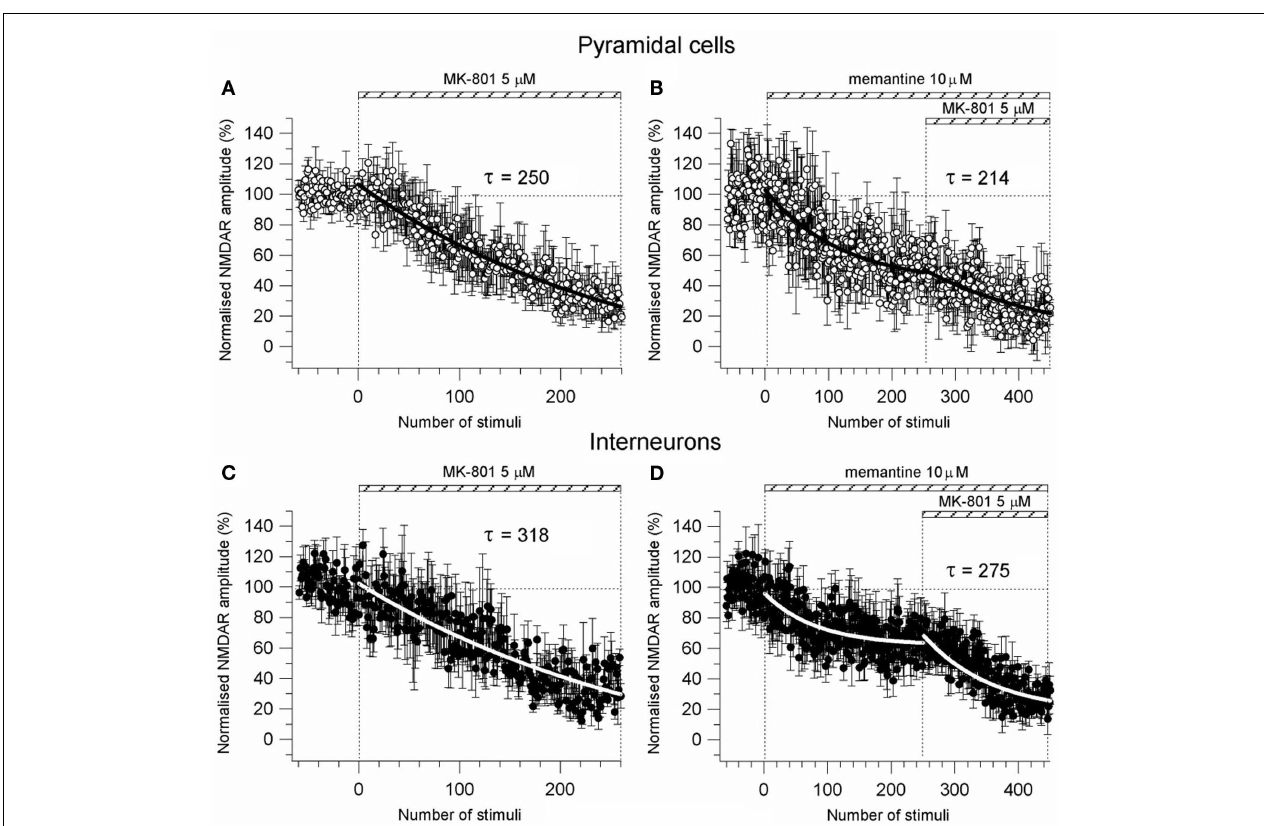
of the NMDAR current amplitude in PCs ( n = 4) and Ints ( n = 8), respectively. Normalized NMDAR current amplitudes (%) are plotted as a function of number of stimuli. NMDAR responses were evoked every 5s.The bars indicate the duration of drug application.The time-courses were obtained by fitting the curves with a single exponential [ y = A 1exp( − t / τ )] (solid bold lines).